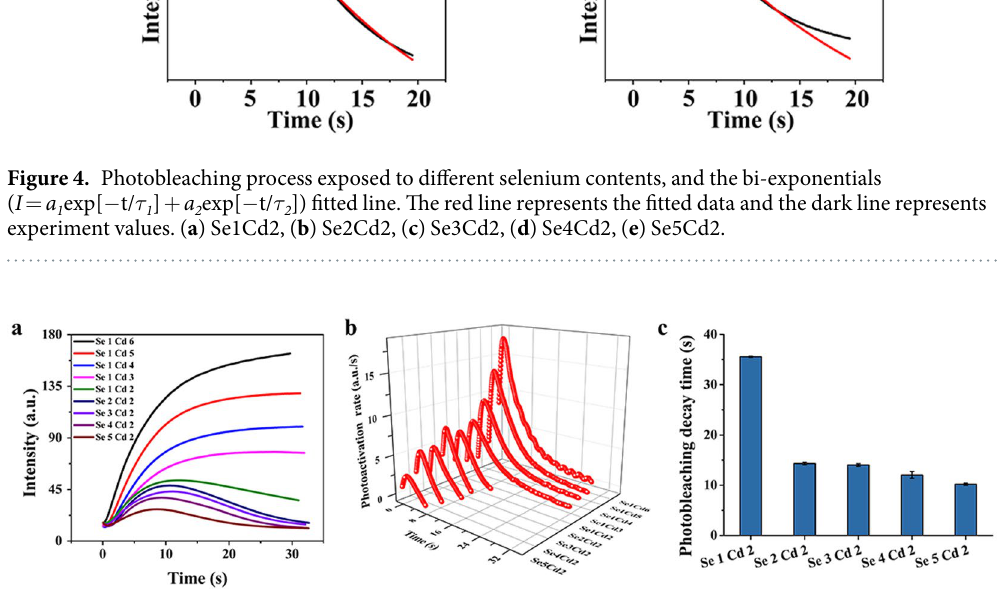
Figure 5. Fluorescence properties of the bio-QDs in C . utilis WSH02-08. ( a ) Intracellular mean fluorescence intensity trajectories in different synthesized bio-QDs recorded under lamp illumination using fluorescence microscopy; ( b ) The derivative of non-linear function of the photoactivation process under different synthesis conditions; ( c ) Best-fit photobleaching decay time constants for the bi-exponential form of the bio-QDs. All the experiments were conducted under the same